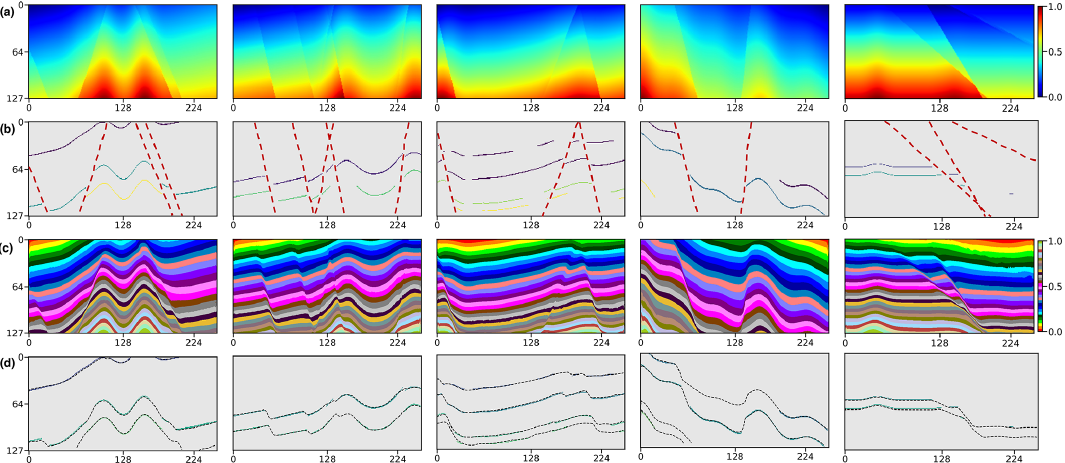
Figure 7. We apply the trained CNN to the five geological models (a) not included in the training dataset. We randomly generate horizon and fault structural data (b) from the models as the inputs of our network. By visual comparison, the modeling results (c) are nearly identical to the ground truth of the models (a) , which can be supported by the great consistency between the scalar field iso-lines (dashed curves) and the input horizons (solid curves) in panel (d)